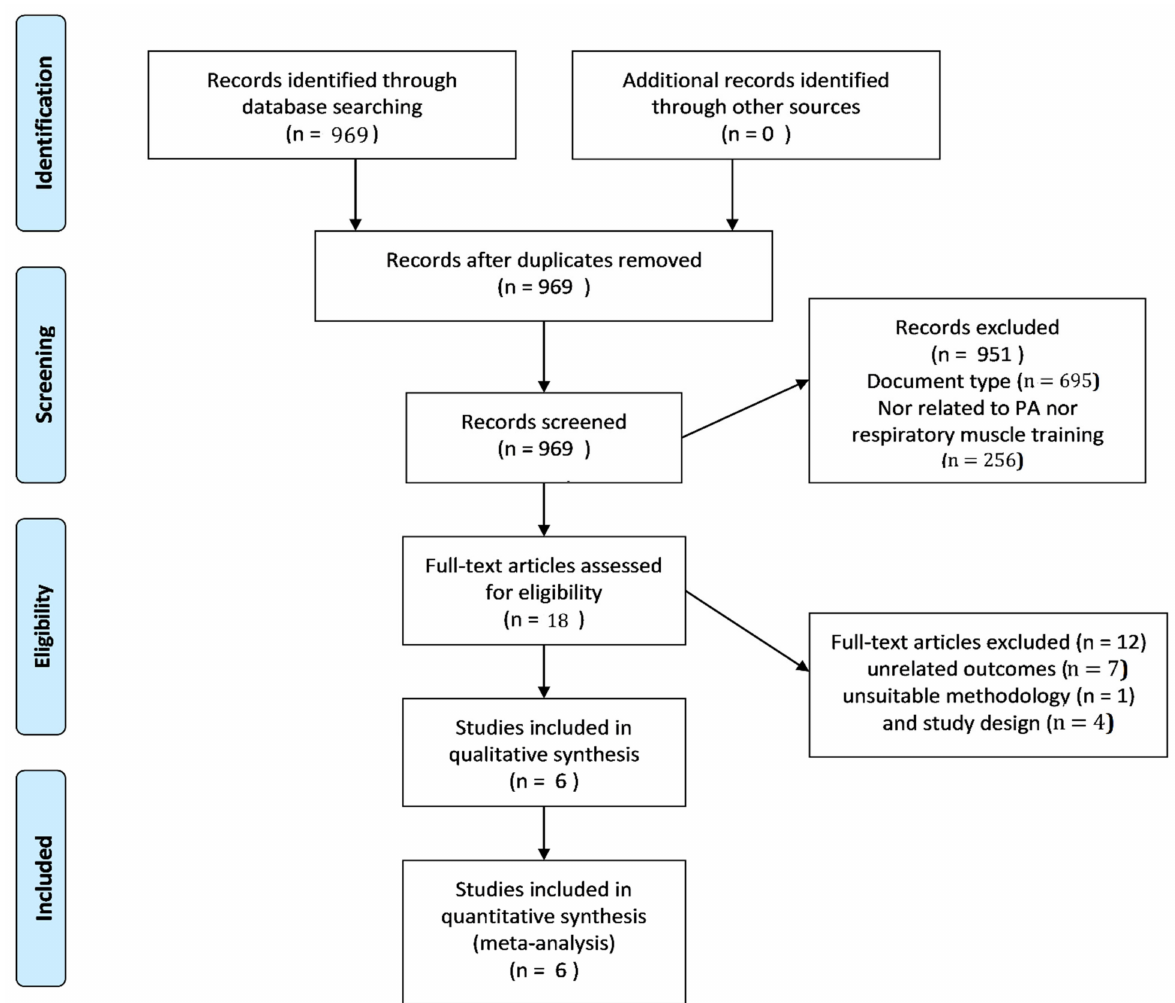
Figure 1. Preferred Reporting Items for Systematic Reviews and Meta-Analyses (PRISMA) flow diagram study selection process for the systematic